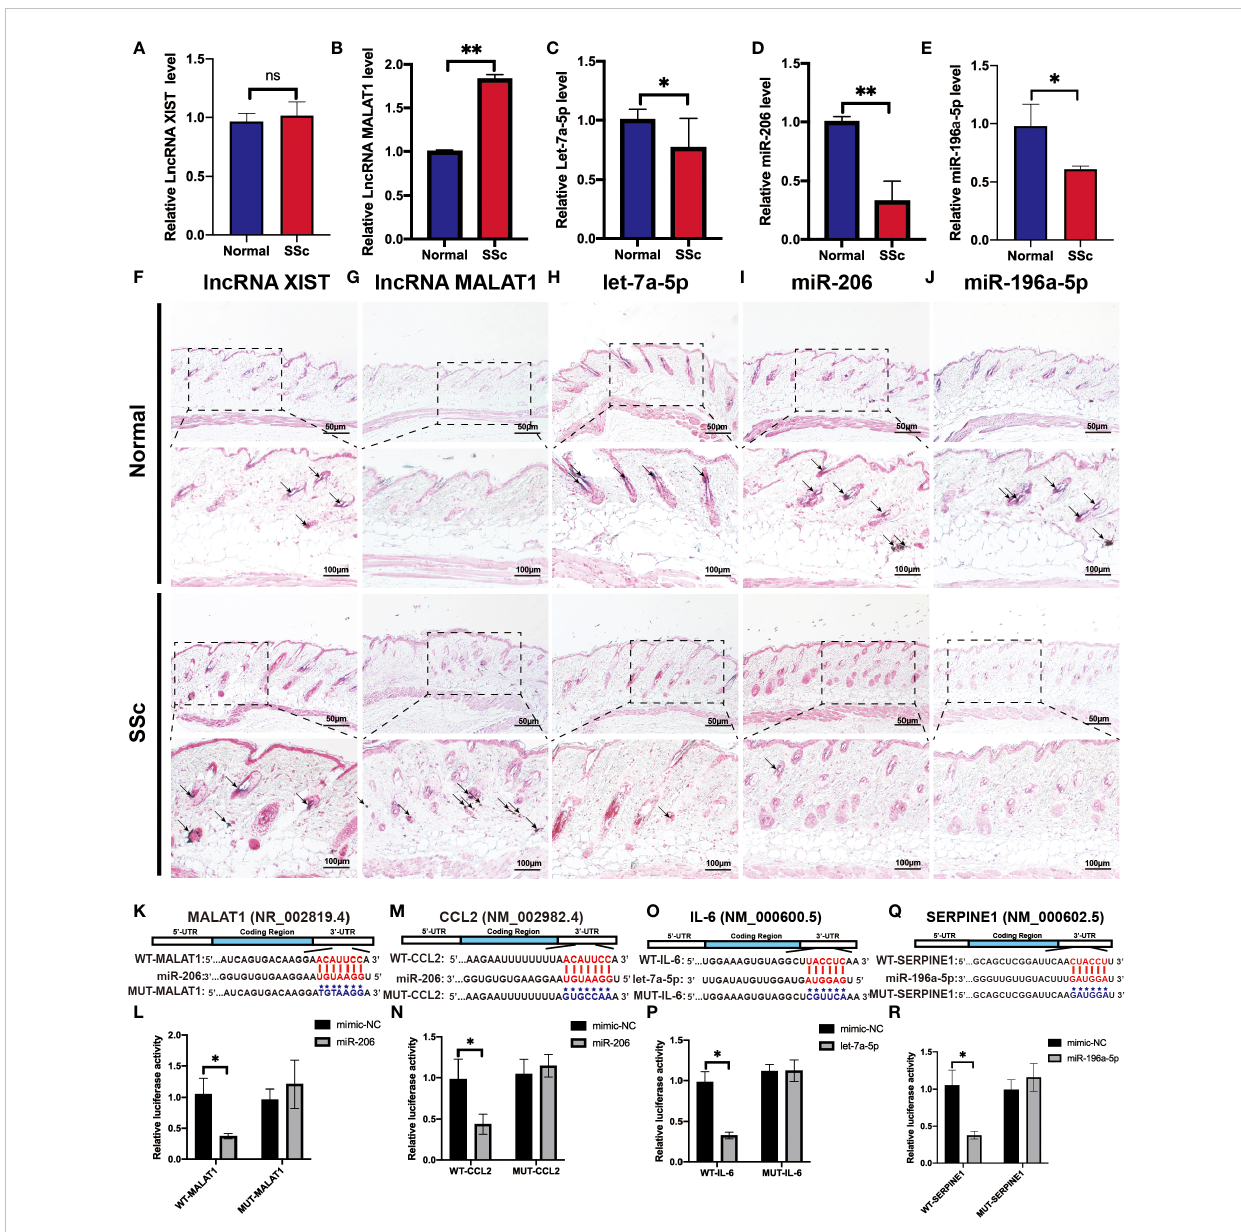
FIGURE 8 Veri fi cation of the potential RNA regulatory pathways in the SSc mouse model. (A-E) Quanti fi cation of LncRNA XIST, LncRNA MALAT1, let-7a-5p, miR-206, and miR-196a-5p mRNA in normal control mice and the SSc mouse model. (F-J) Representative ISH images showed the expression of LncRNA XIST, LncRNA MALAT1, let-7a-5p, miR-206, and miR-196a-5p in normal control mice and the SSc mouse model. (K) Potential binding sites of MALAT1 to miR-206. (L) Luciferase reporter gene assays were performed to con fi rm the direct targeting of MALAT1 to miR-206. (M) Potential binding sites of CCL2 to miR-206. (N) Luciferase assays were performed to con fi rm the direct targeting of CCL2 to miR-206. (O) Potential binding sites of IL-6 to let-7a-5p. (P) Luciferase reporter gene assays were performed to con fi rm the direct targeting of IL-6 to let-7a-5p. (Q) Potential binding sites of SERPINE1 to miR-196a-5p. (R) Luciferase reporter gene assays were performed to con fi rm the direct targeting of SERPINE1 to miR-196a-5p. Scale bar 50 and 100 m m. *P < 0.05, **P < 0.01 ns, means no signi fi cant differences. Black arrows represent positive in situ hybridization signals